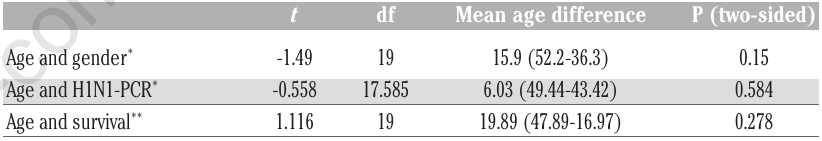
Table 1. Age t-test statistics: age among H1N1- polymerase chain reaction, survival, and gender groups.